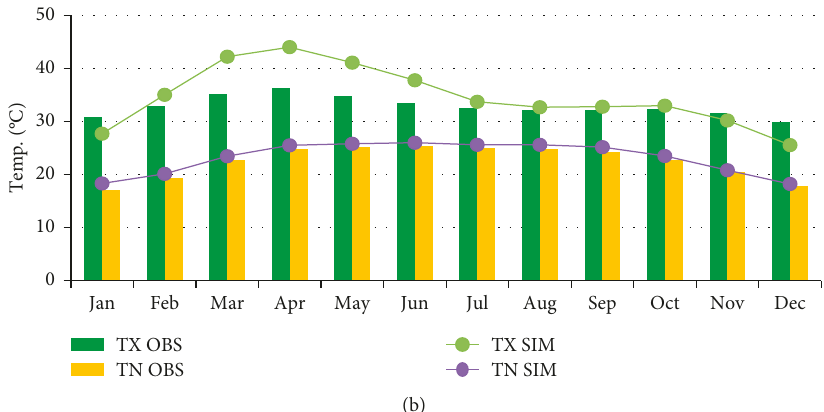
Figure 15: Goodness of fit from observed climate stations and PRECIS data after reduced tolerances for Mukdahan station. (a) PC: B2 scenario. (b) TX and TN: B2 scenario.